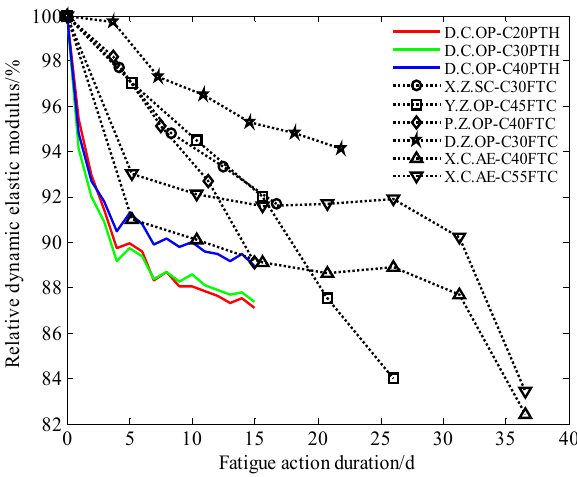
ff erent fatigue